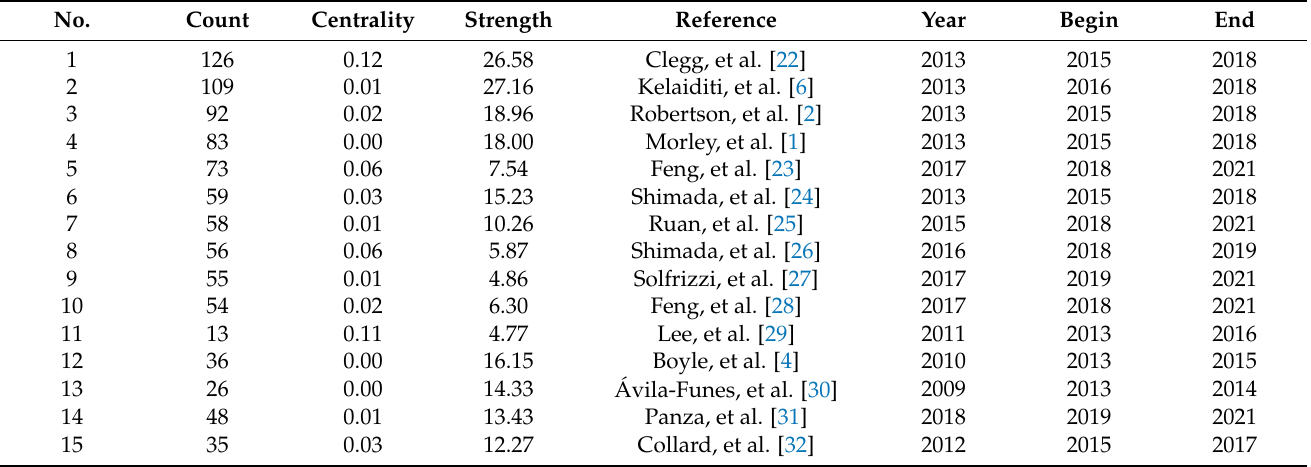
Table 2. Fifteen representative references in terms of citations, centrality, and bursts.